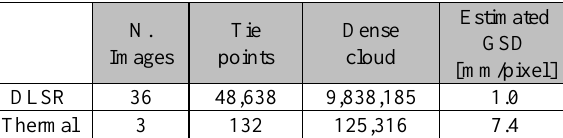
Table 4. Main details of the photogrammetric process.